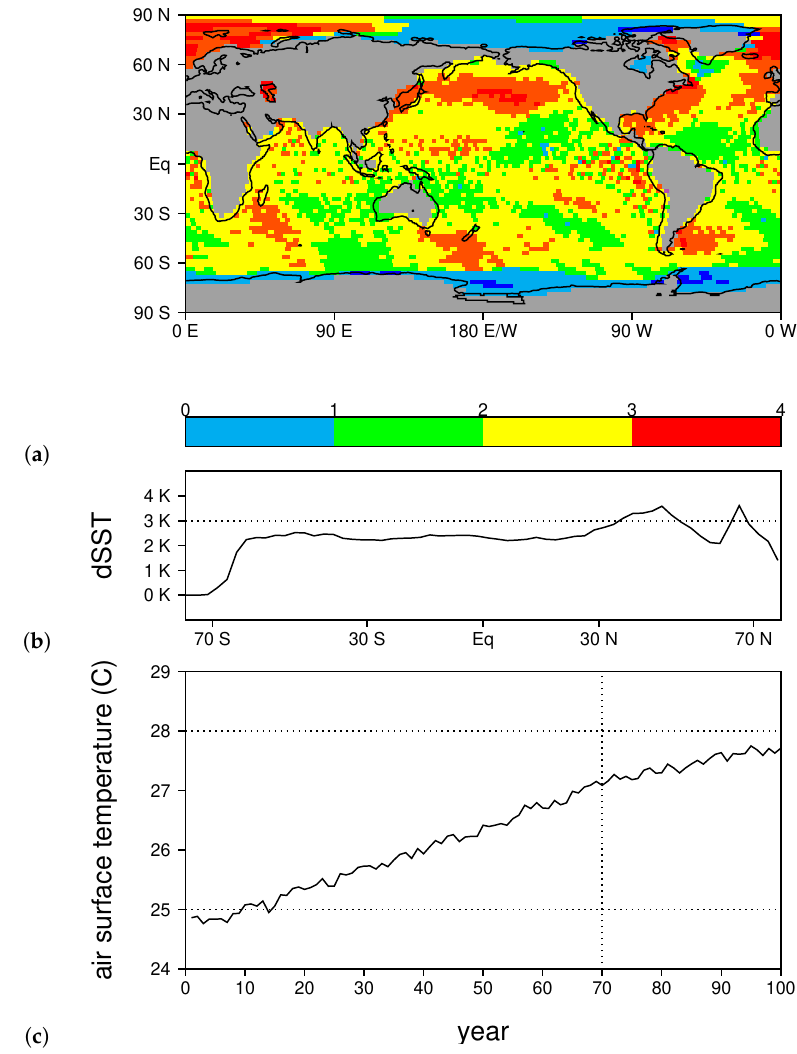
Figure 3. Metrics of global warming. ( a ) Difference in average sea surface temperature (SST) between Years 1–10 and Years 91–100 (C). ( b ) Longitudinal average of panel ( a ). ( c ) Average surface air temperature over 30 S to 30 N. The vertical dotted line in panel ( c ) indicates when the non-water-vapor longwave optical depth has reached its maximum